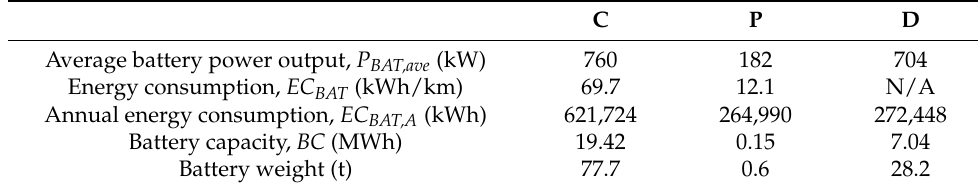
Table 6. Battery-powered ship input data for LCA.